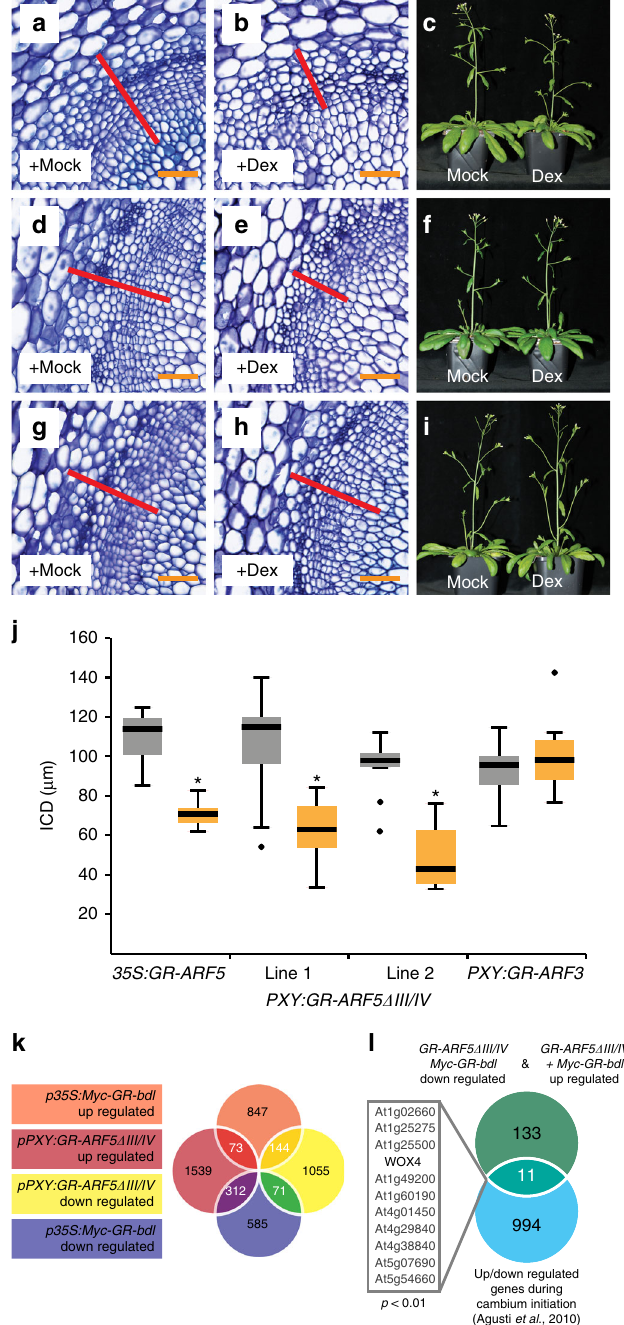
Fig. 4 ARF5 attenuates cambium proliferation. a , b , d , e , g , h Toluidine blue- stained cross-sections at the stem base of p35S:GR-ARF5 ( a , b ), pPXY:GR- ARF5 Δ III/IV ( d , e ) and pPXY:GR-ARF3 ( g , h ) plants after long-term mock ( a , d , g ) or Dex ( b , e , h ) treatment. Interfascicular regions are shown and ICD tissues are marked (red bar). Size bars represent 50 µ m. c , f , i Overview pictures of p35S:GR-ARF5 ( c ), pPXY:GR-ARF5 Δ III/IV ( f ) and pPXY:GR-ARF3 ( i ) plants after long-term mock or Dex treatment. j Quanti fi cation of ICD tissue extension at the stem base of p35S:GR-ARF5 , pPXY:GR-ARF5 Δ III/IV and pPXY:GR-ARF3 plants after long-term mock (grey) or Dex (yellow) treatment. Student ’ s T -test ( p35S:GR-ARF5 p = 3.03E-05, pPXY:GR- ARF5 Δ III/IV (line 2) p = 1.34E-05, pPXY:GR-ARF3 p = 0.37) and Welch ’ s T - test ( pPXY:GR-ARF5 Δ III/IV (line 1) p = 9.72E-04) were performed comparing mock and Dex treatment (Sample sizes n = 6 – 10). The T -bars that extend from the boxes (whiskers) are expected to include 95% of the data. Signi fi cance is indicated by the asterisk. k Venn diagram of RNA sequencing results from RNA obtained from second internodes of p35S: Myc-GR-bdl and pPXY-GR-ARF5 Δ III/IV plants after mock or Dex treatment. Identi fi ers of 600 overlapping genes are shown in Supplementary Data 1.